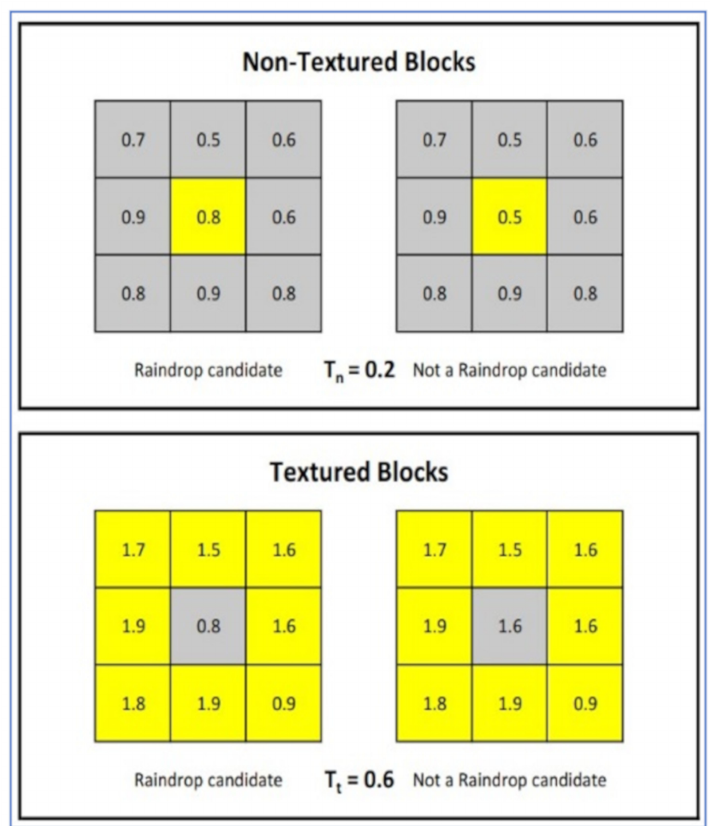
Figure 17. Raindrop candidate pixels are chosen based on the difference between their degree of blur value and those of the neighboring pixels